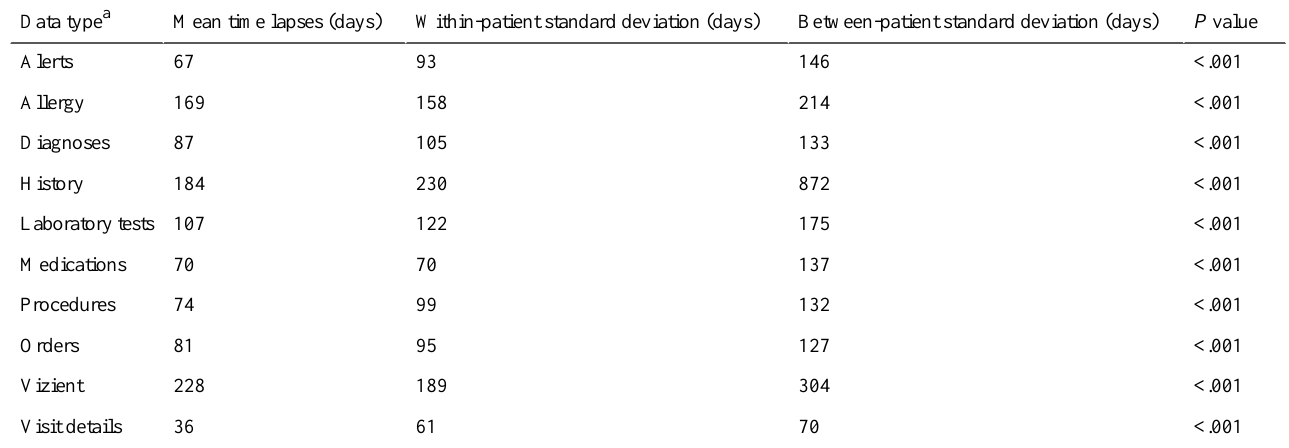
Table 2. Clinical observation